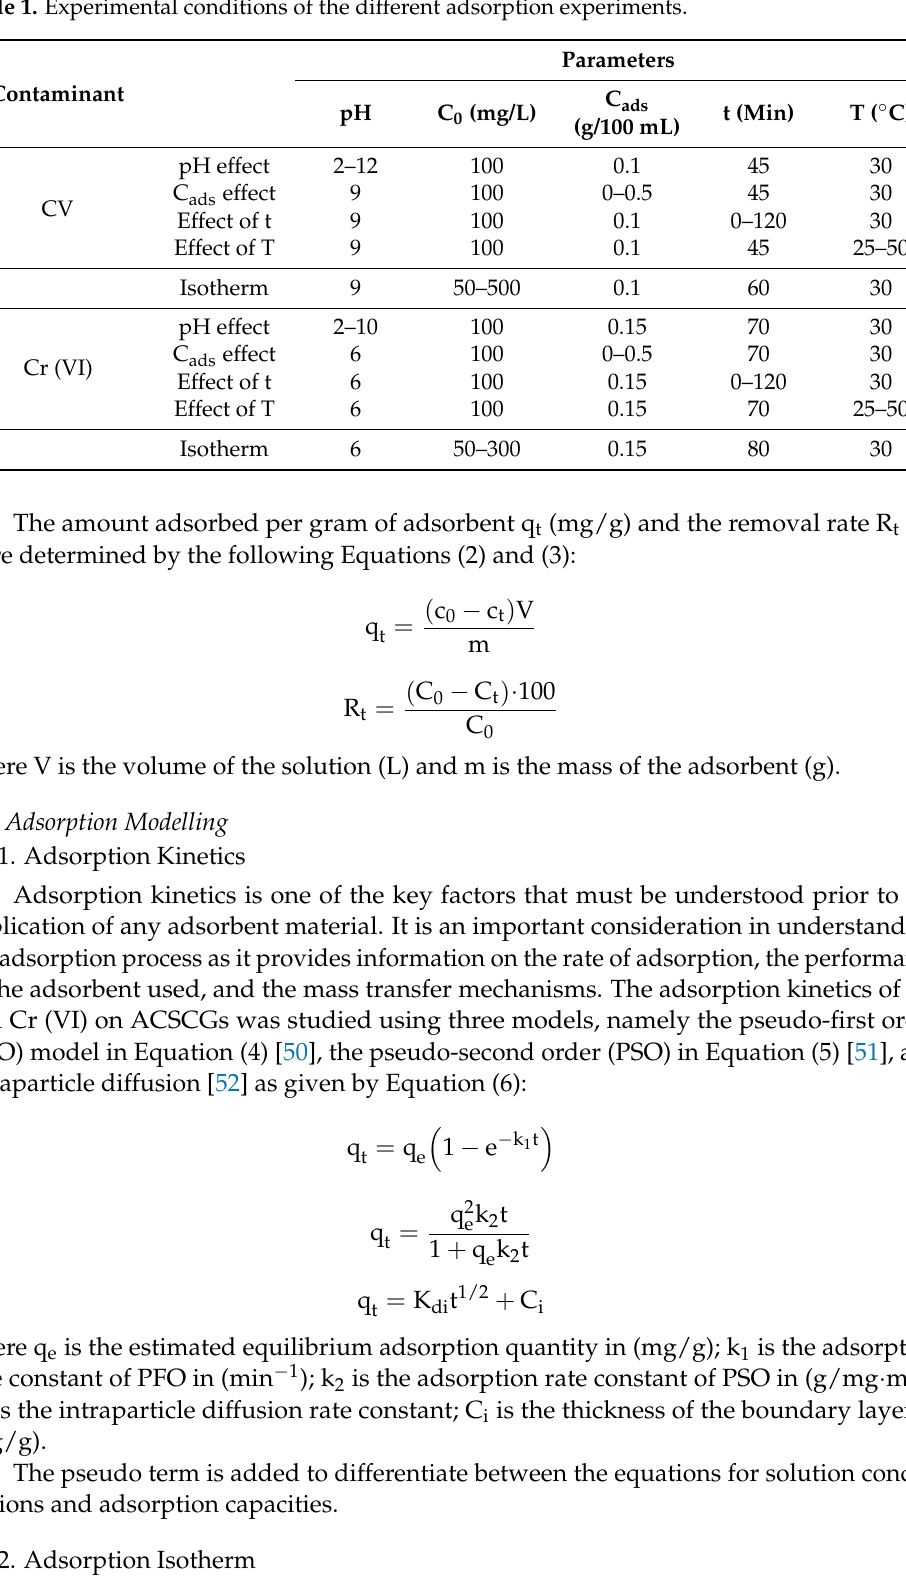
Table 1. Experimental conditions of the different adsorption